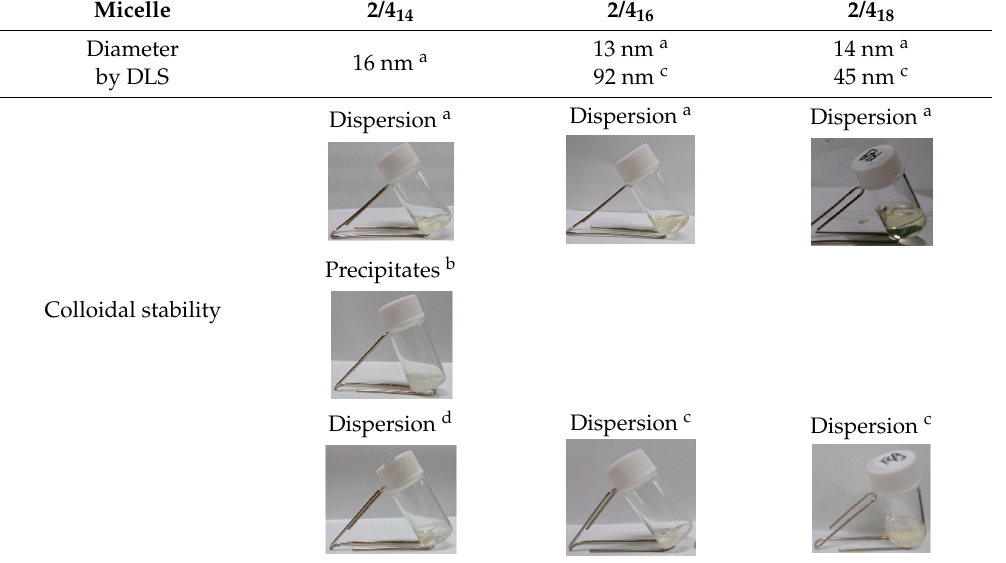
Table 1. Mean diameters and colloidal stability of the mixed micelles 2 / 4 n ( n = 14, 16, and 18) in phosphate-buffered saline (PBS) at 30 ° C.